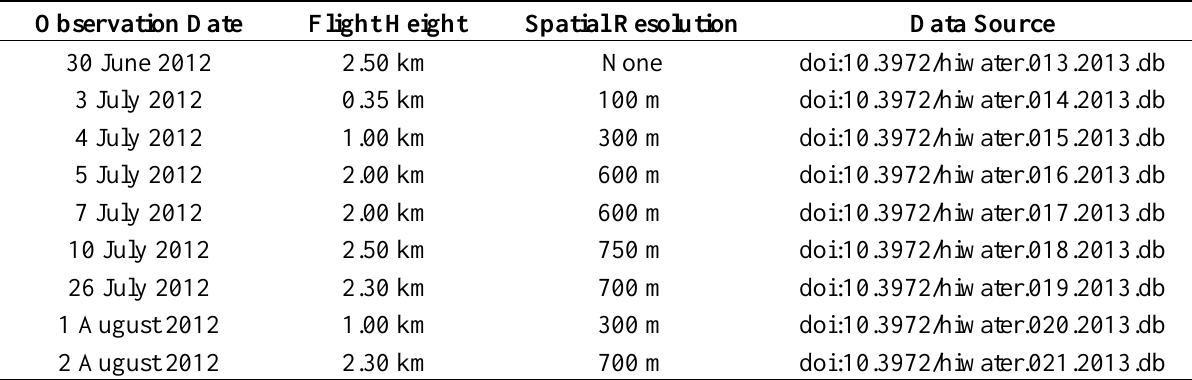
Table 1. Measurement details of the PLMR